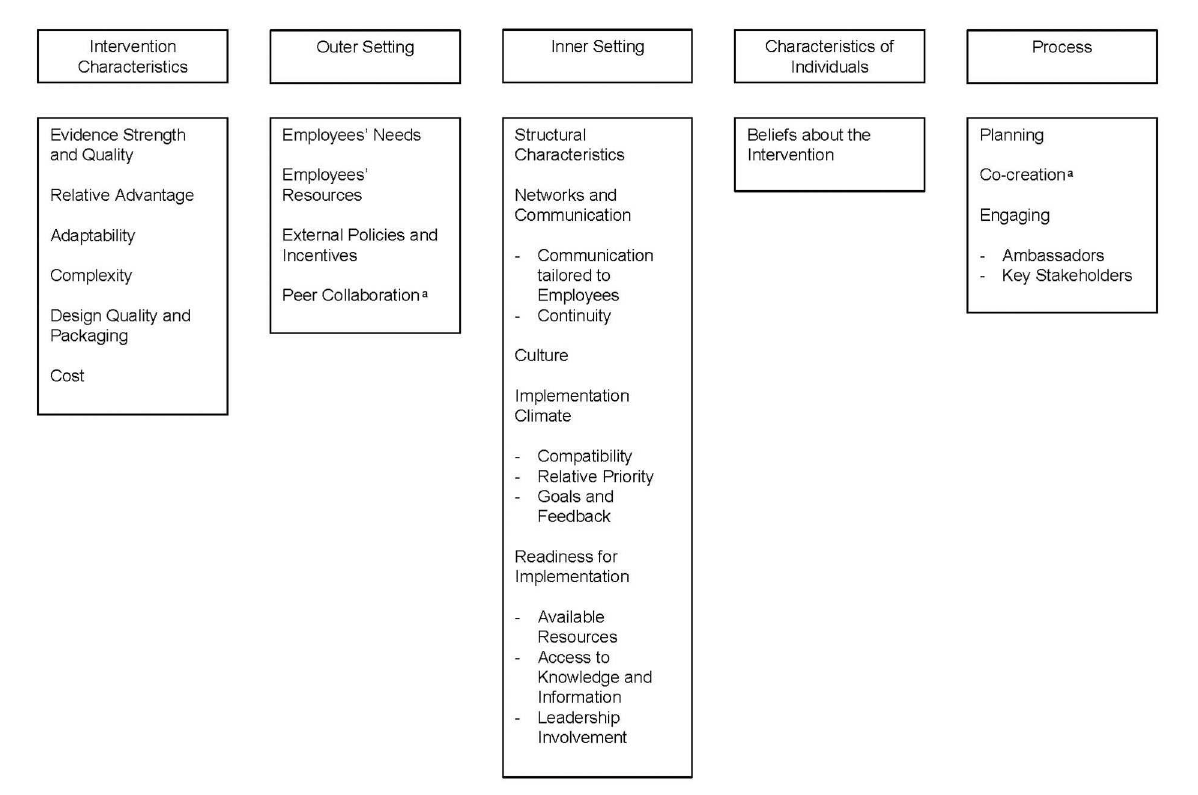
FIGURE1 Overview of the condtructs in which barriers and facilitators were identified, categorized according to the five domains of the CFIR. a Emerged inductively as a construct.